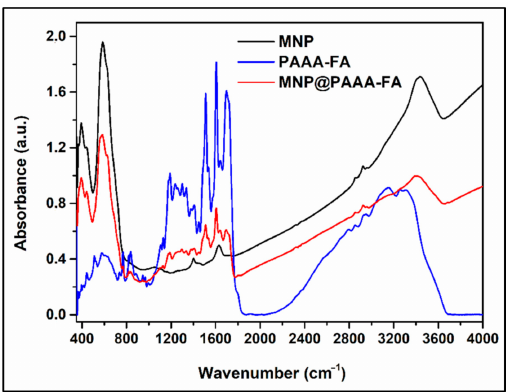
Figure 1. FTIR spectra of uncoated MNP , PAAA-FA and the MNP@PAAA-FA magnetic nanostructure collected between 400 and 4000 cm − 1 using 1.92 mg of sample as pressed pellets embedded in